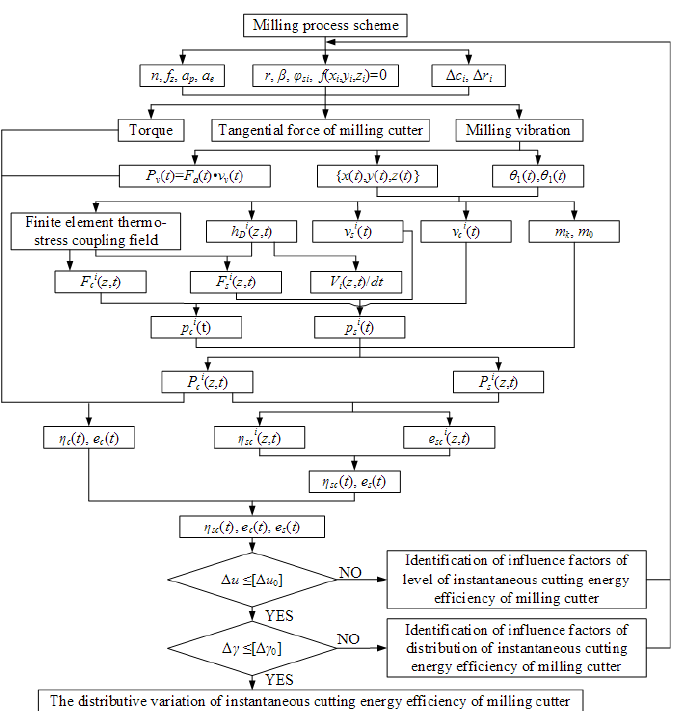
Figure 18. Modeling and distribution identification of instantaneous cutting energy efficiency of milling cutter under vibration.